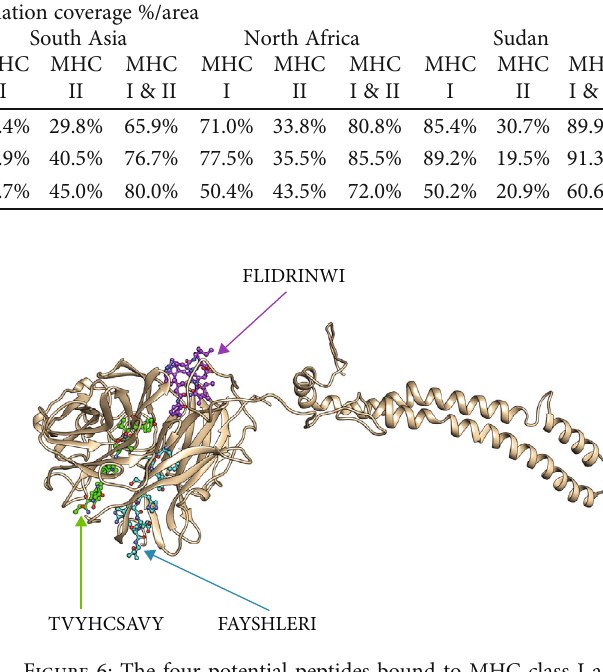
Table 5: Population coverage of the three highly proposed peptides in MHC classes I and II in fi ve di ff erent parts of the world. Peptide